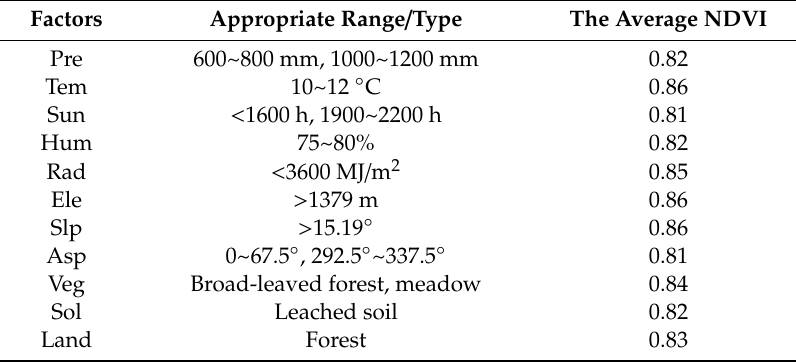
Table 5. The factor range / type suitable for vegetation